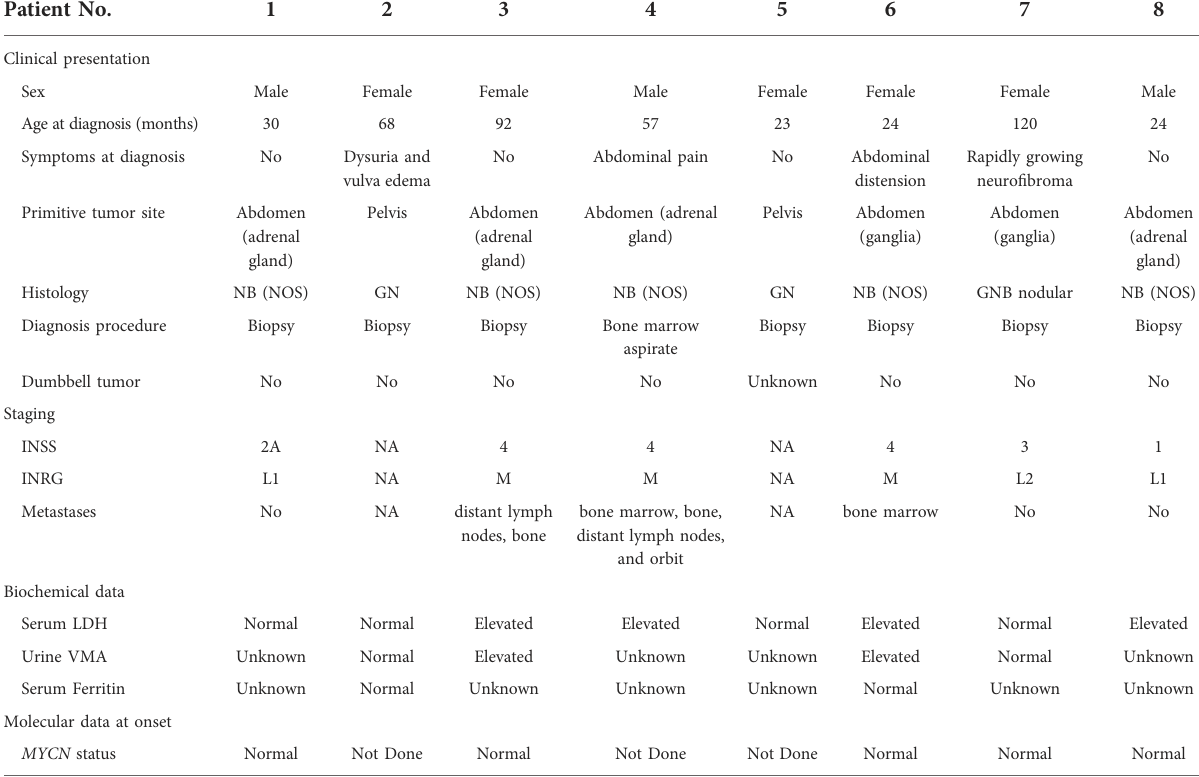
TABLE 1 Characteristics of the tumor in eight patients. Patient